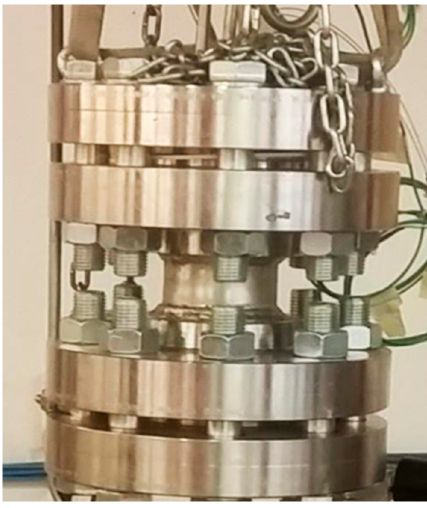
Figure 2. Image of the lab-scale apparatus used for hydrate formation tests.